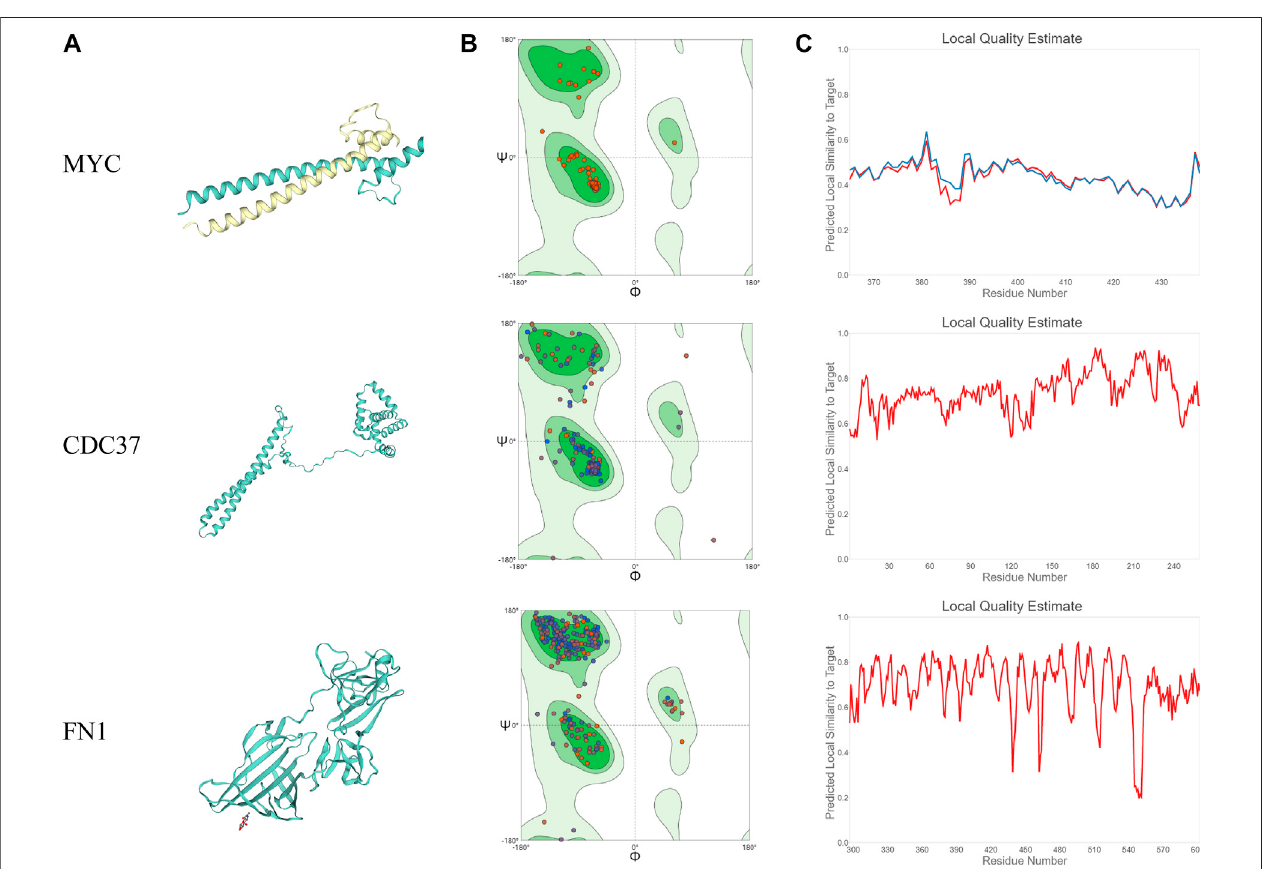
FIGURE 5 | Analysis of the MYC, CDC37, and FN1 protein structures. (A) 3D visualization ofthe structures ofMYC, CDC37, and FN1. (B) Ramachandran plots of MYC, CDC37, and FN1. (C) The local quality estimate graphs of MYC, CDC37, and FN1.